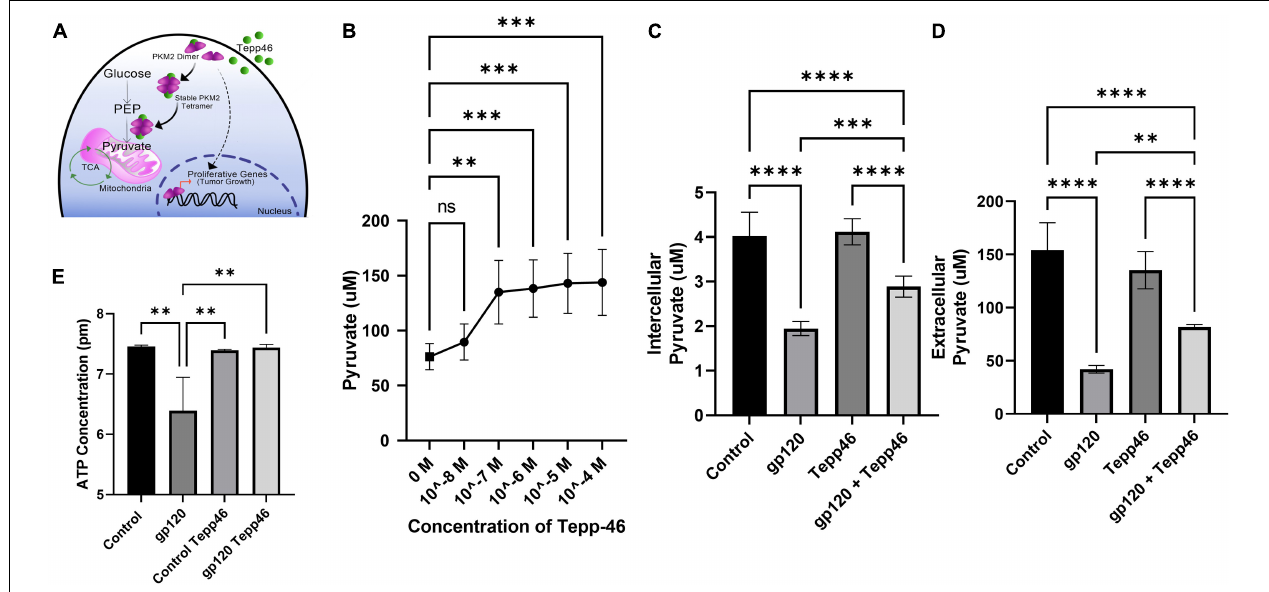
FIGURE 7 | Tepp-46 and its effect on pyruvate production. (A) A schematic illustration of the mechanism of action of Tepp-46 has on PKM2 and its correlation to pyruvate production and the effect on mitochondrial metabolism. (B) Concentrations of intercellular pyruvate in undifferentiated LUHMES cells treated with increasing concentration of Tepp-46 as indicated. (C,D) Differentiated LUHMES cells untreated or treated with 100 ng/ml of gp120 and/or 10 nM of Tepp-46. The concentration of intracellular (C) and extracellular (D) pyruvate were measured. Bar graphs represent means ± SD. (E) Measurement of ATP concentration in LUHMES cells untreated or treated with 100 ng/ml of gp120 and/or 10 nM of Tepp-46. Data represent the mean ± S.D. Results were judged statistically significant by the ANOVA test ( ∗∗ p < 0.01, ∗∗∗ p < 0.001, ∗∗∗∗ p <